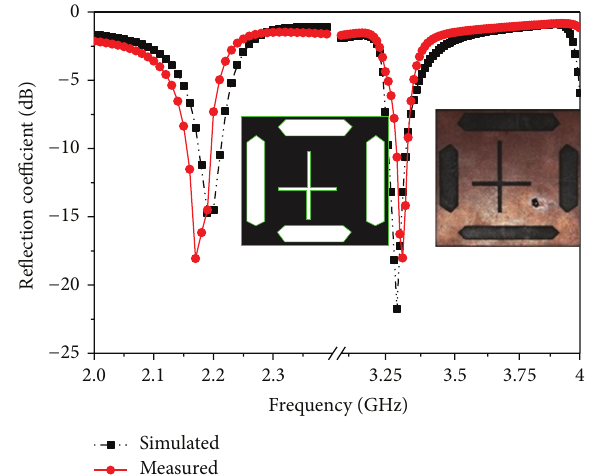
Figure 10: Comparison between simulated and measured return losses of the proposed antenna.